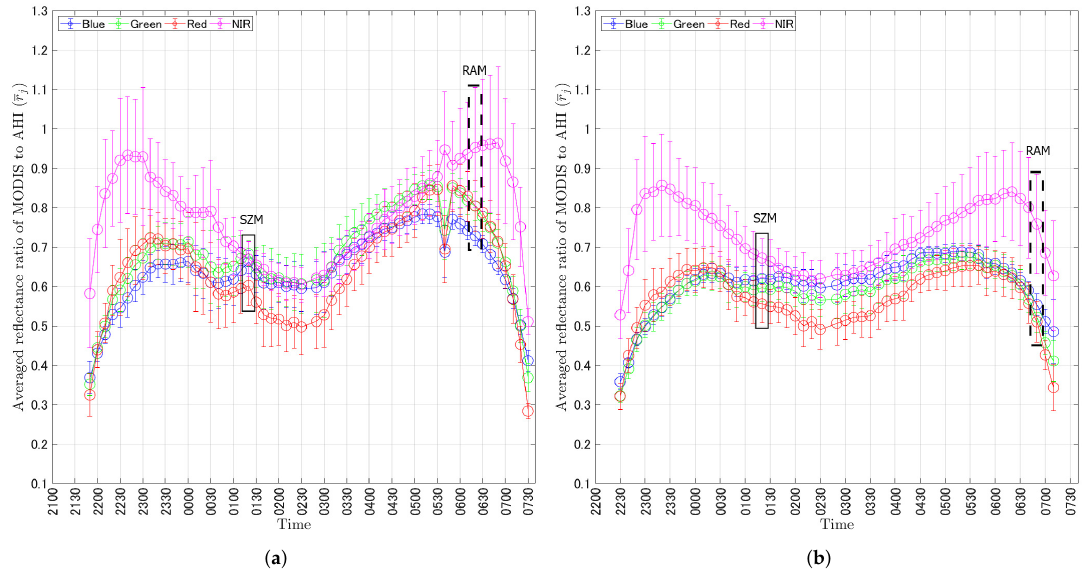
Figure 12. The r j values for four bands along the UTC time, from sunrise to sunset, calculated using composite data collected using the algorithm described in Section 4.2: ( a ) AichiForest on 9 November 2017; and ( b ) AichiForest on 22 December 2015. Rectangles depicted by the solid and dashed lines indicate the times selected using the SZM and RAM methods,